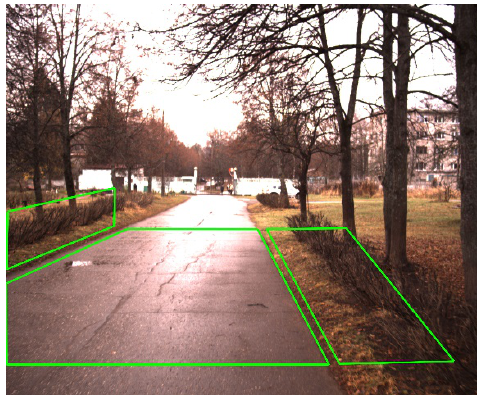
Figure 5 . of the stereo unit (one frame of the stereo system is shown).